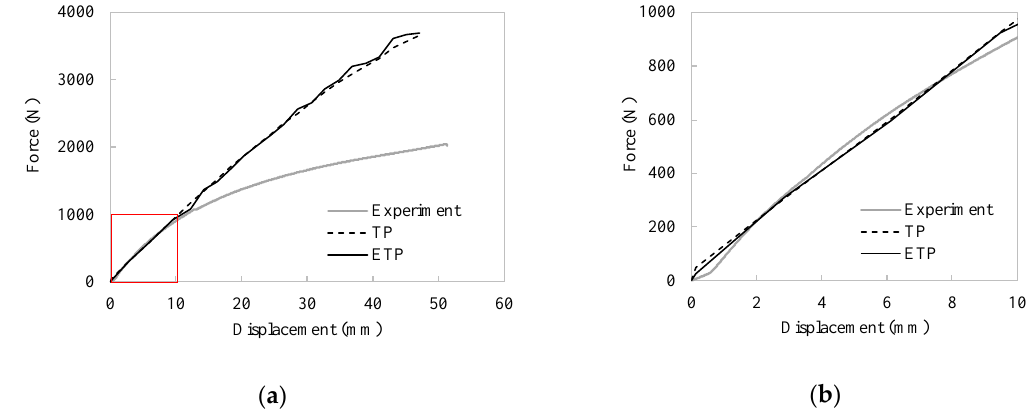
Figure 22. Force–displacement relations obtained by the experiment and the synthetic structural analysis: ( a ) complete test range and ( b ) linear elastic stage.